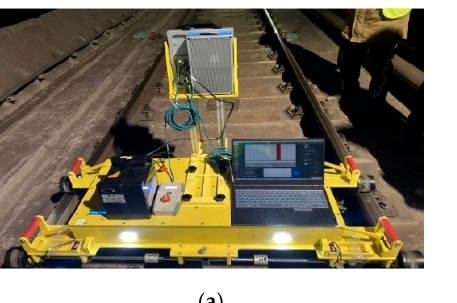
Figure 12. ( a ) The experimental field and ( b ) laser point cloud data of the shield tunnel.